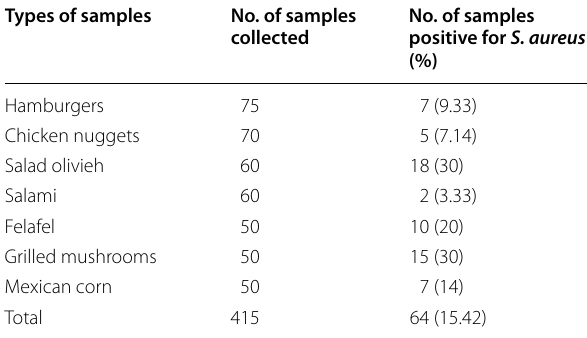
Table 1 Prevalence of S. aureus in diverse kinds of ready-to-eat food